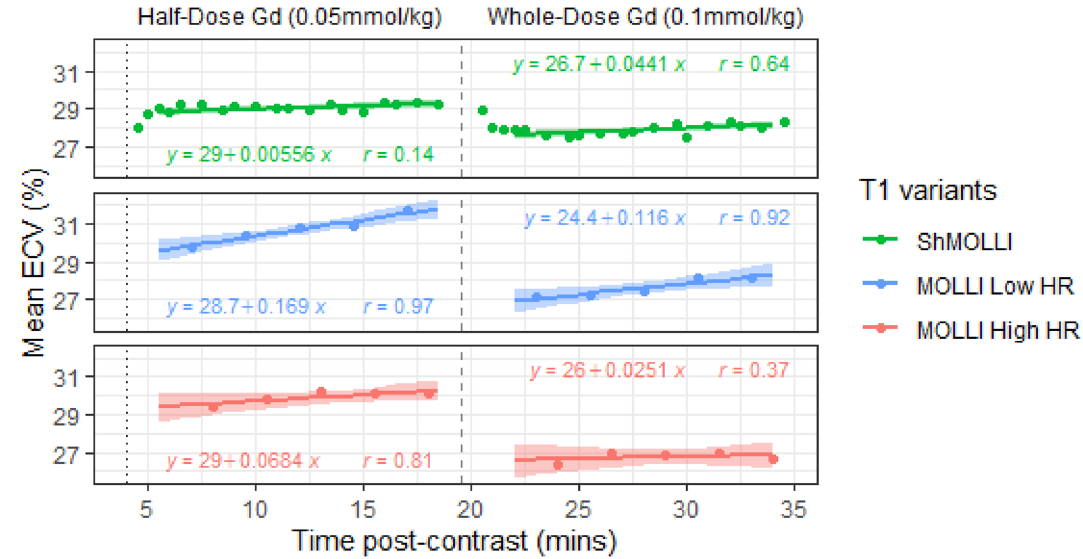
Figure 5. Effect of time and gadolinium dose on ECV. Linear regressions are shown for half-dose and whole- dose Gd epochs. Stress was reversed at 4 min (dotted vertical line); Gd was given at 0 min and a second dose at 19 min (dashed vertical line). The early rapid variation in ECV estimates after Gd seen in the ShMOLLI panel (data points outside the ranges marked by regression models) were excluded from analysis to allow fair inter-method comparisons. ShMOLLI ECV demonstrates little change in ECV with time, whereas MOLLI ECV (particularly MOLLI Low HR) is subject to linear time drift. Confidence intervals for the linear regressions are included (shaded ranges).